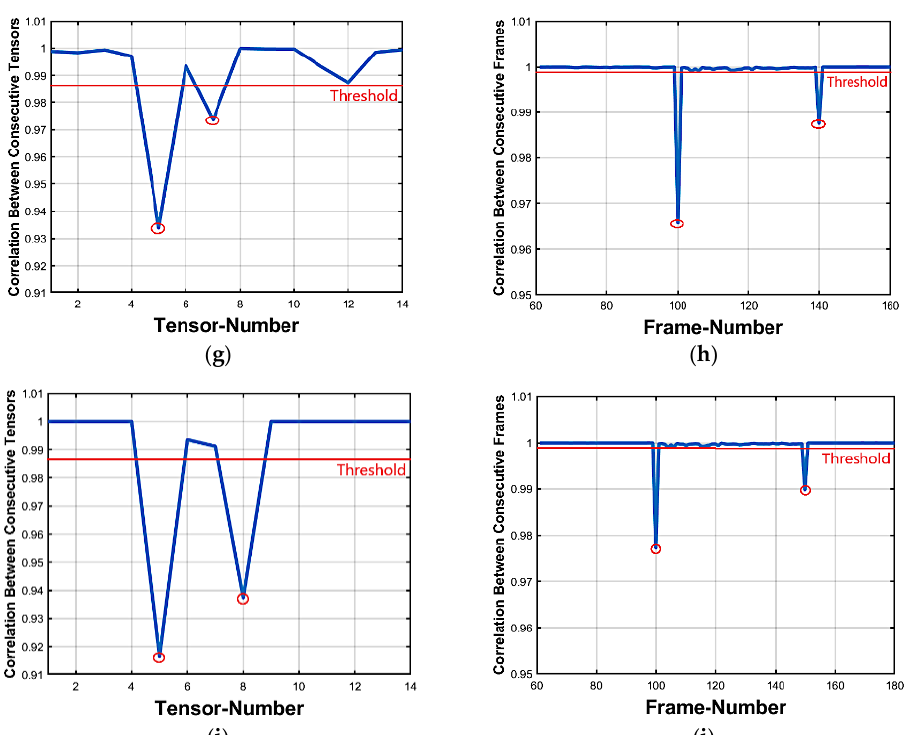
Figure 8. ( a , c , e , g , i ) insertion forgery detecting and ( b , d , f , h , j ) insertion forgery locating of 10, 20, 30, 40 and 50 forged frames respectively.